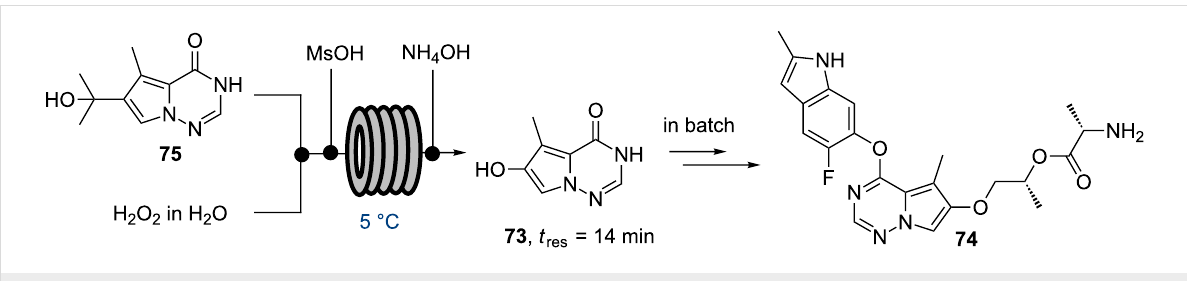
Scheme 12: Pilot scale flow synthesis of key intermediate 73 .